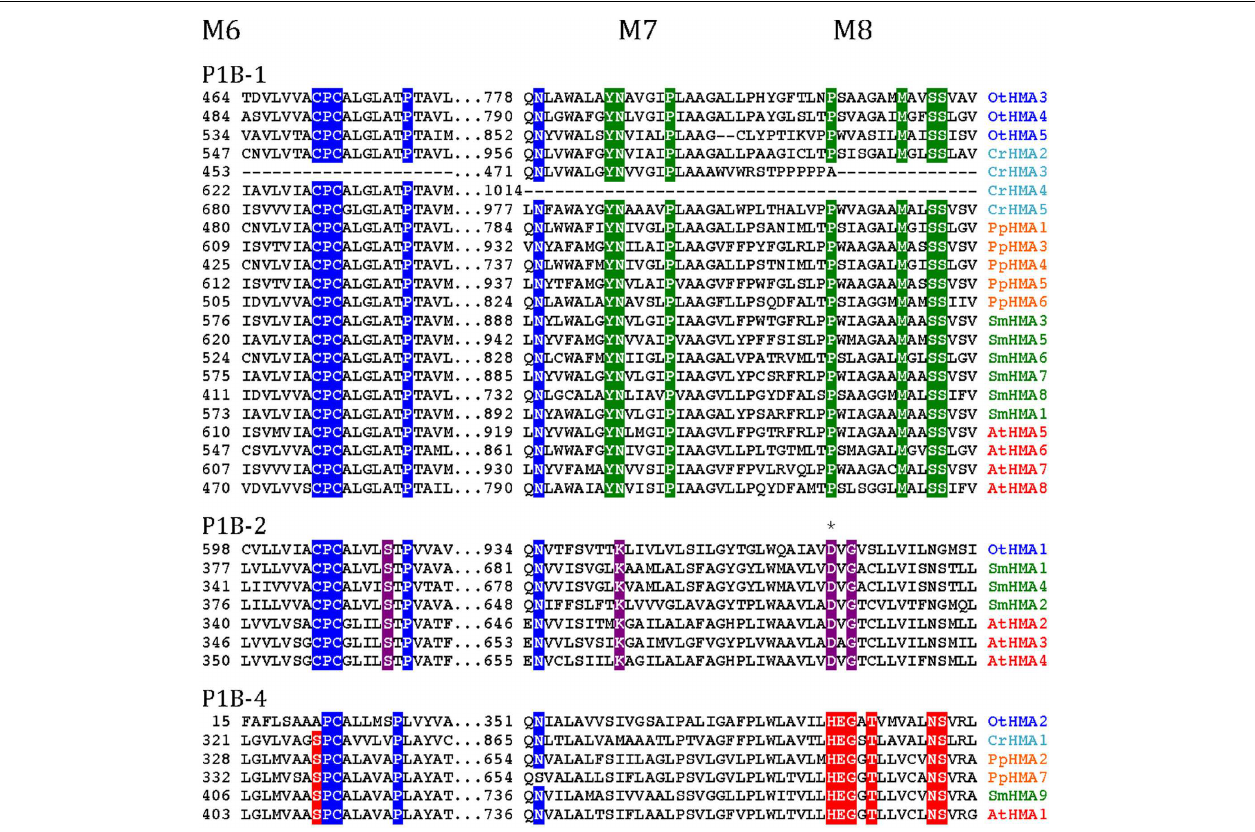
FIGURE 4 |Alignment of three transmembrane segments fromViridiplantae P1BATPases analyzed in this study. Only the predicted transmembrane segments M6, M7, and M8 are shown. P1B-1: Cu + transporting ATPases; P1B-2: Zn 2 + transporting ATPase: P1B-4: Mixed specificity heavy metal pumps.The asterisk indicates an Asp residue (D) conserved in P1B-2 ATPases, which could be important for coordination of Zn 2 + (Dutta et al., 2006).